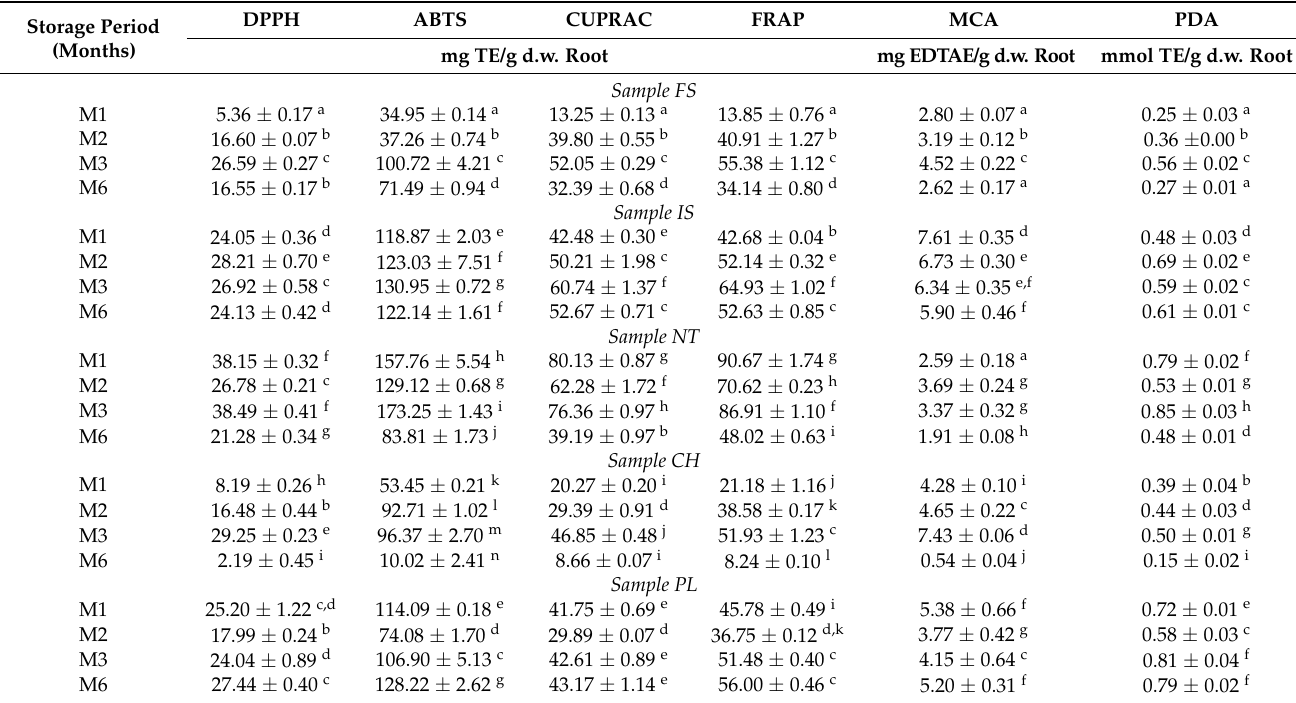
Table 3. Assessment of the antioxidant activity of comfrey ( S. officinale ) roots collected from different European regions and stored for 1–6